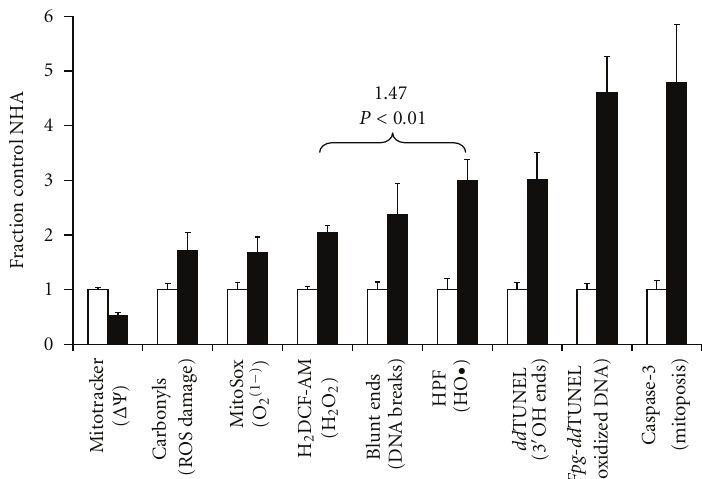
Figure 6: Summary of observed changes in NHA following incubation with ethylmercury. Bar plot showing the summarized changes observed in NHA following a one-hour exposure to 14.4 µ M Thimerosal, with respect to untreated controls. Each value is expressed as mean ± SD of five fields measured in the center field of triplicate experiments. Each of the treated values is statistically di ff erent from the controls at P < 0 . 01. The increase in HO • is statistically di ff erent from the increase in H 2 O 2 (H 2 DCF-AM) at P < 0 . 01. Statistical analyses were performed using one-way analysis of variance (ANOVA) with the Holm-Bonferroni post hoc test. The test was performed only when the results of ANOVA were P < 0 . 05, using Daniel’s XL Toolbox, a free, open source add-in for Microsoft